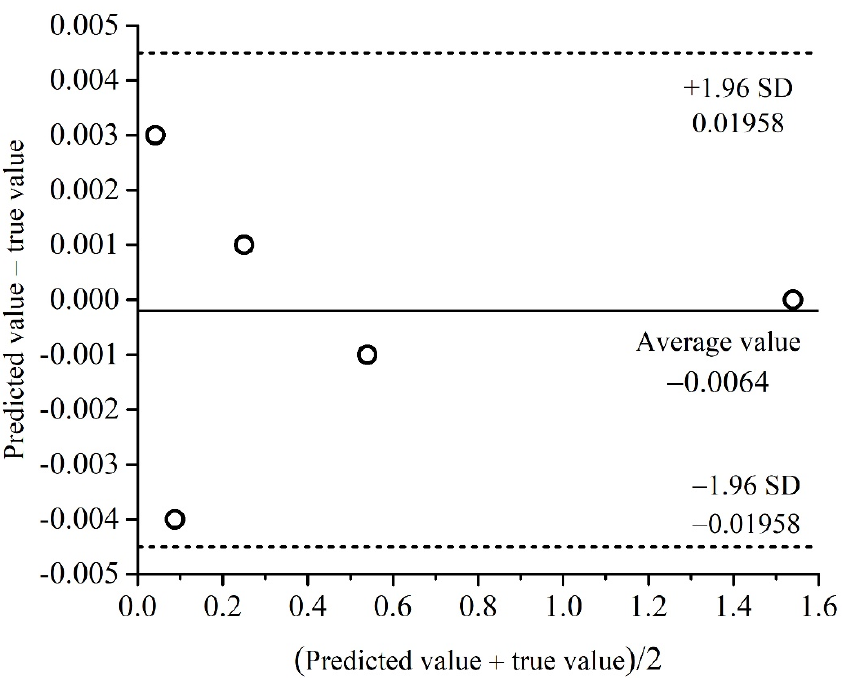
Figure 3. Results of the Bland–Altman analysis.